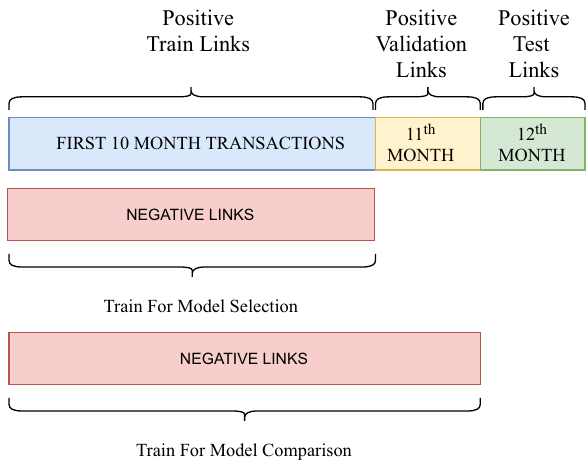
Figure 2. Data partition visualization.